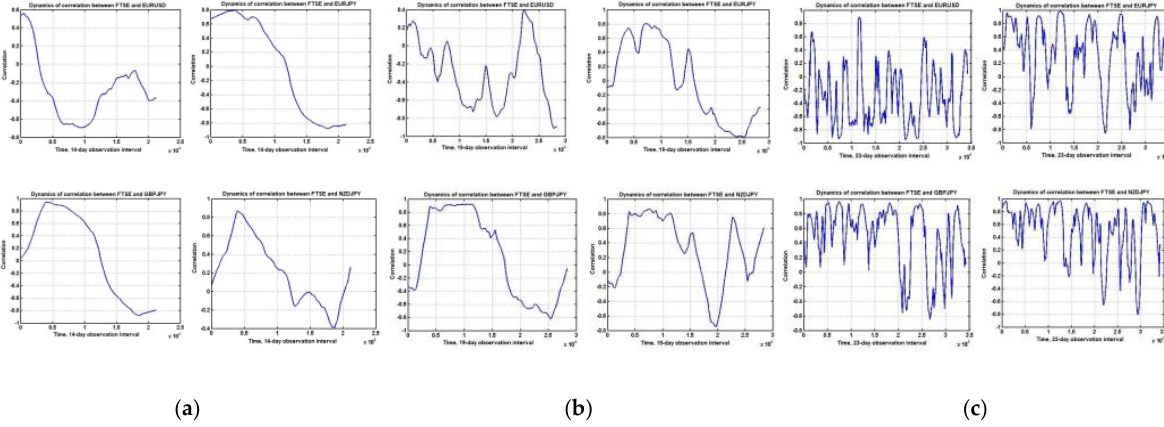
Figure 3. Correlation changes between EURUSD, EURJPY, GBPJPY, and NZDJPY on a sliding observation window of ( a ) 14 days, ( b ) 19 days, and ( c ) 23 days.